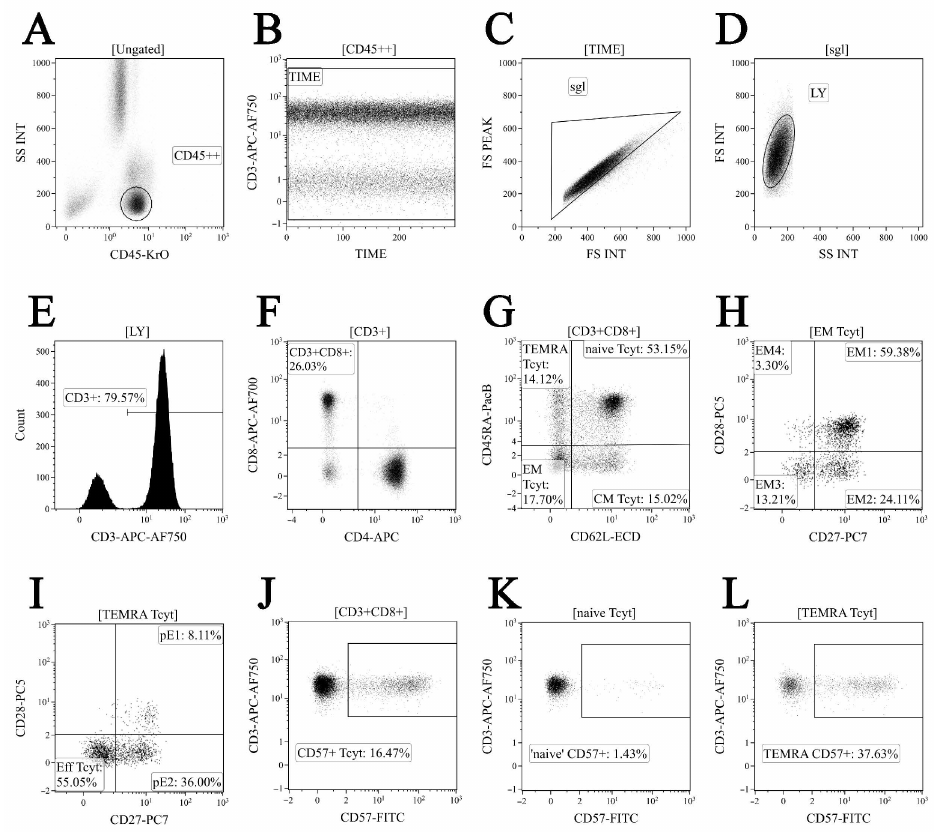
Figure 1. Flow cytometry immunophenotyping gating strategy for CD8+ T cell subset maturation stages and assessing CD57 expression level (shown in dot plots). ( A ) Total lymphocyte subset purifi- cation based on side scatter and bright CD45 expression; ( B ) artifact exclusion included time